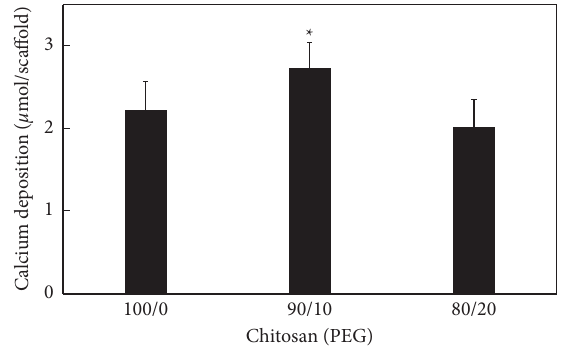
Figure 5: Calcium deposition of osteoblast following 15days in osteogenic media in the CHI-100, CHI-90, and CHI-80 scafolds. Te values represent mean ± standard deviation, n � 4. ∗ indicates p < 0.05; ∗∗ indicated p < 0.001 vs. PEG-100 and PEG-90; PEG-100 and PEG-80.